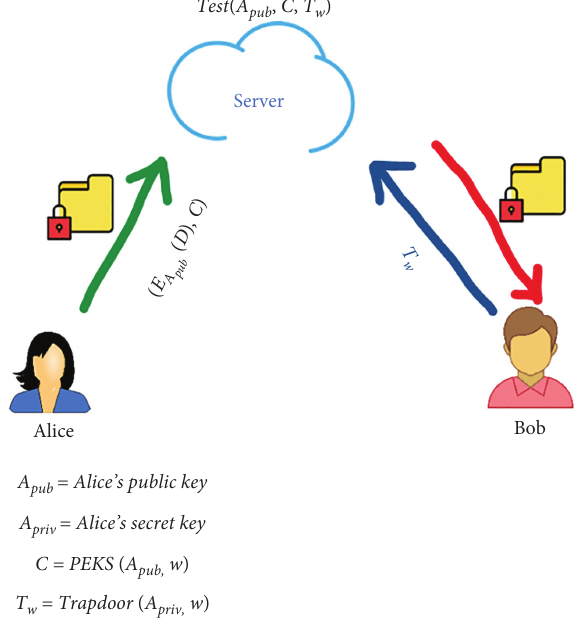
Figure 1: The PEKS